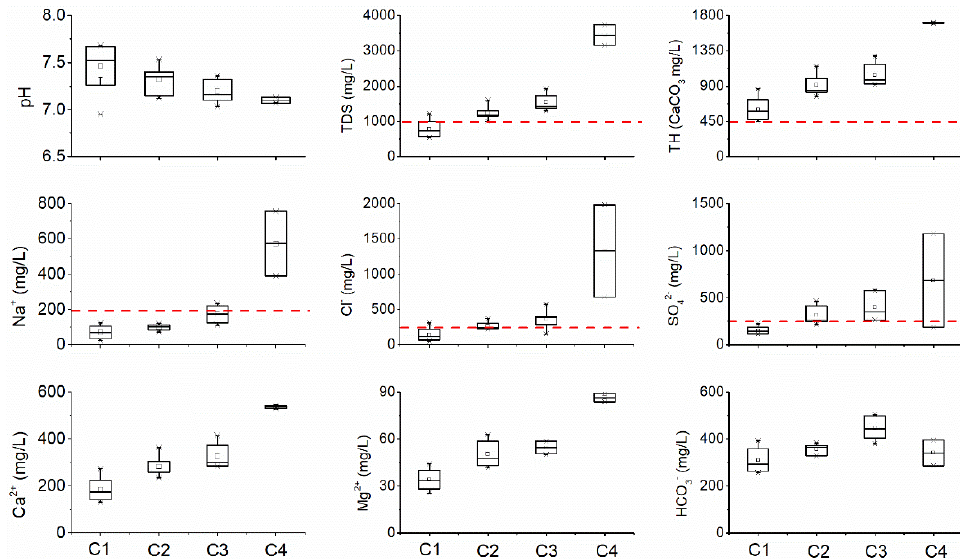
Figure 4. Box diagrams of conventional hydrochemical indexes of different types of groundwater in the study area.